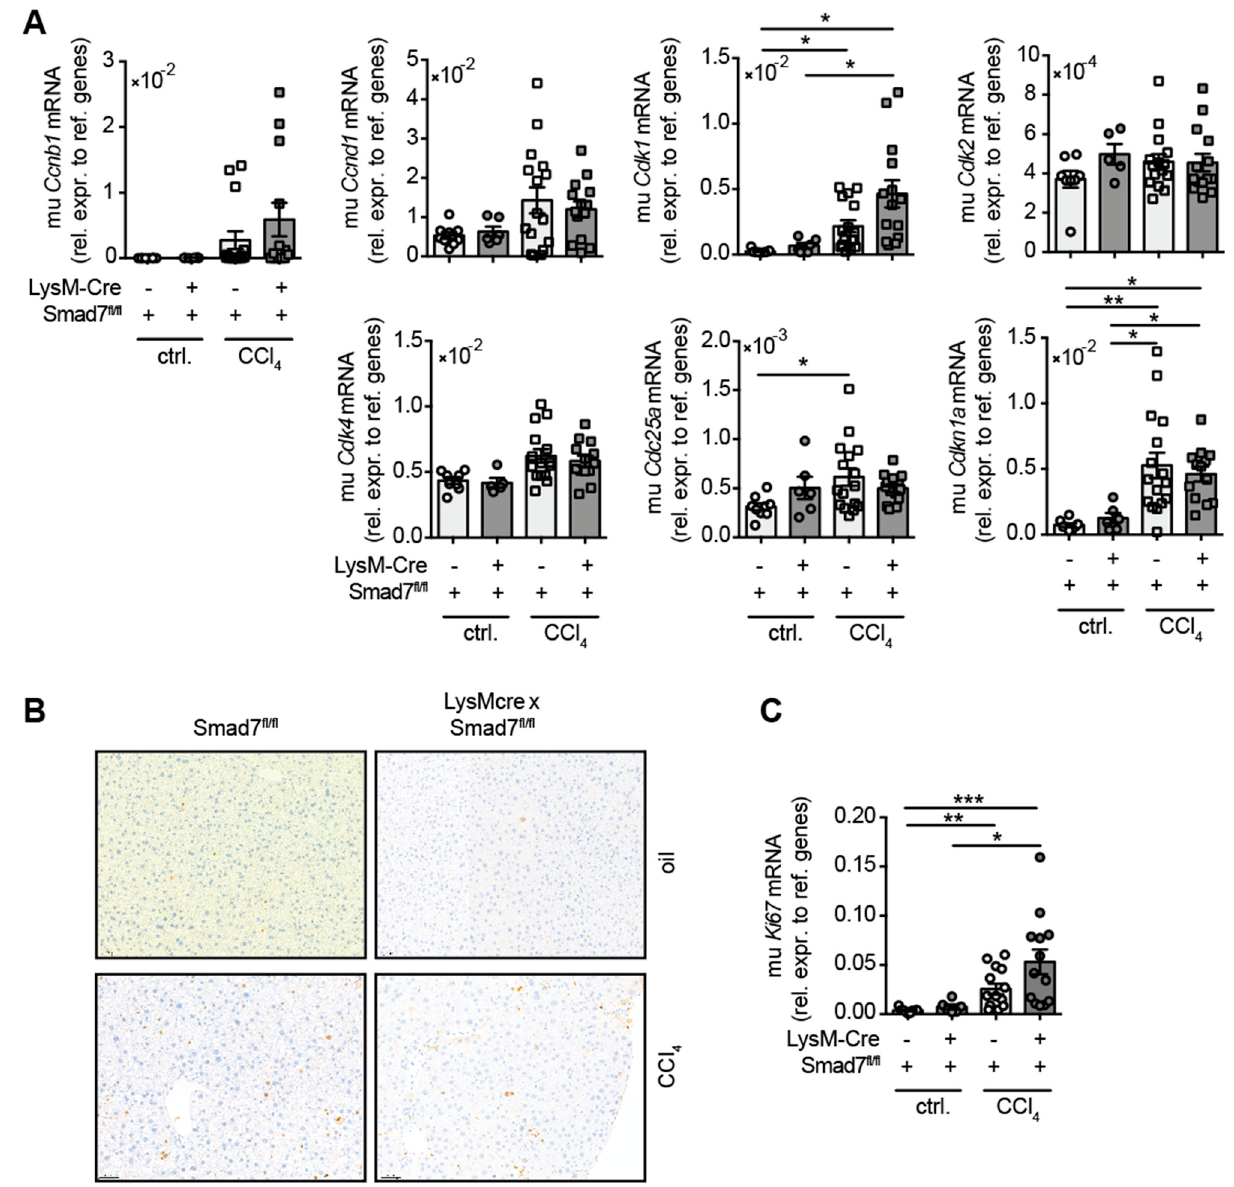
Figure 4. Hepatic expression of cell cycle genes in CCl 4 -treated Smad7-proficient and -deficient animals. LysM-Cre pos Smad7 Δ / Δ and Smad7 fl/fl littermates were injected intraperitoneally with CCl 4 in corn oil or corn oil alone (ctrl.) twice a week for 6 wks. Mice were sacrificed 24 h after the last CCl 4 –oil application. ( A ) Cell cycle gene expression in the livers of LysM- Cre pos Smad7 Δ / Δ and Smad7 fl/fl littermates measured by qPCR. ( B ) Histological staining of Ki-67 in liver sections of CCl 4 or corn-oil-treated mice shown at 10x magnification. ( C ) Expression of Ki67 mRNA in livers of treated mice as described above. Data shown are cumulative data of 5 independent experiments with 3–5 animals per group. Data are displayed as the mean ± SEM. ANOVA analysis of the data did not reveal significant differences between LysM-Cre pos Smad7 Δ / Δ and Smad7 fl/fl groups after CCl 4 treatment. * p ≤ 0.05, ** p ≤ 0.01, *** p ≤ 0.001.